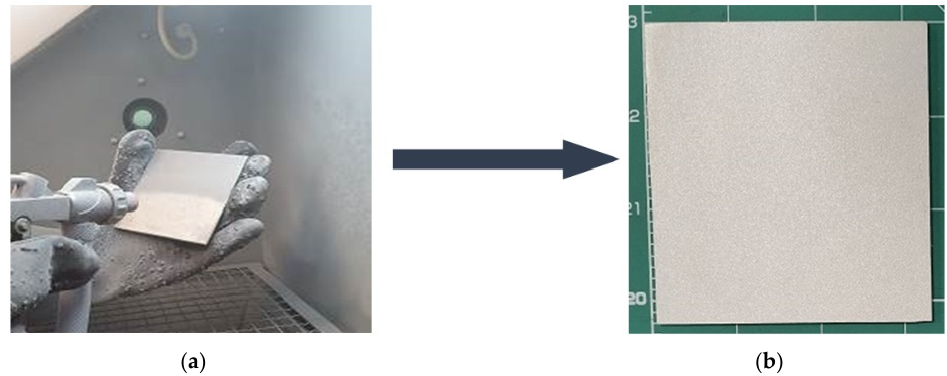
Figure 1. Dry blasting of the aluminum substrate: ( a ) image of the specimen, inside the blasting chamber; ( b ) the surface of the specimen obtained following the blasting process.